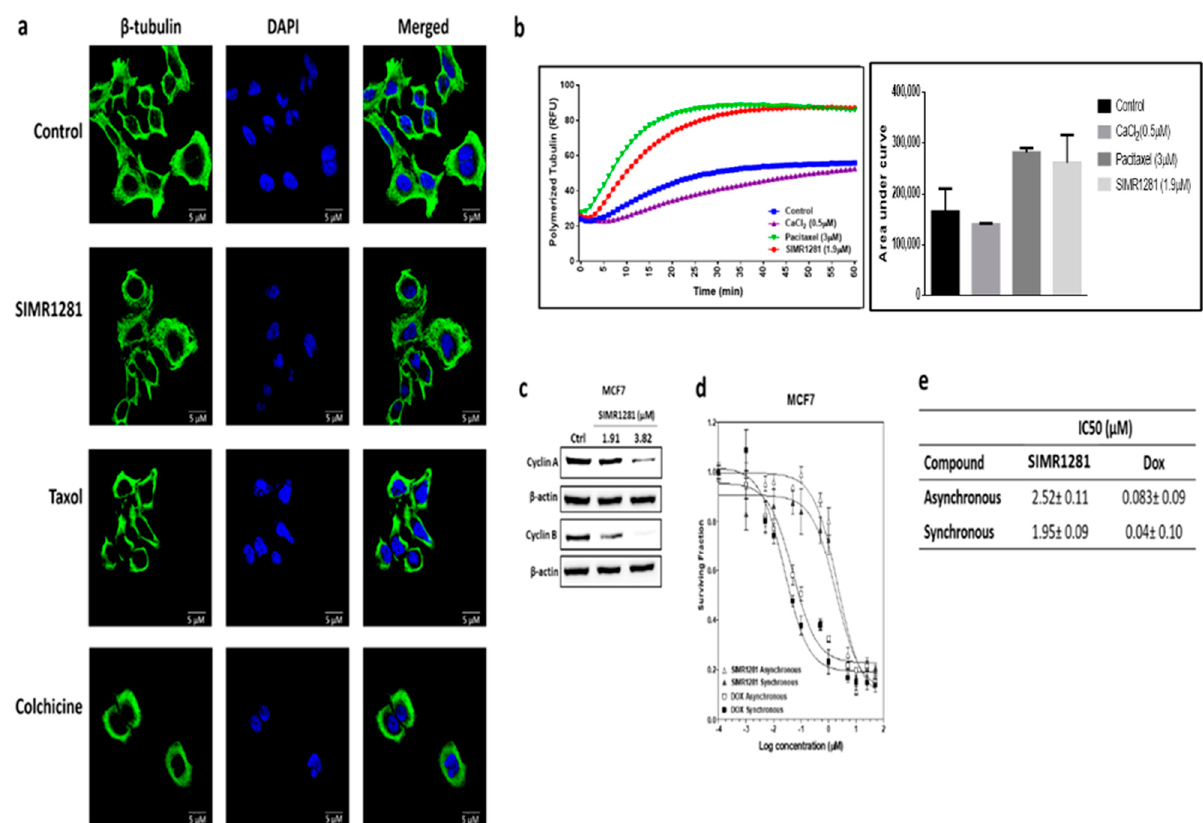
Figure 4. SIMR1281 stabilizes microtubule polymerization. ( a ) Immunofluorescence analysis of tubulin polymerization in A549 cell line after 24 h of treatment with the IC 50 concentration of SIMR1281, taxol, and colchicine (scale bar 5 µm). ( b ) Tubulin polymerization kinetic effect of the treatment with the IC 50 concentration of SIMR1281. ( c ) Western blot analysis of cyclins A and B expression levels following treatment with SIMR1281 in MCF7 cells. ( d ) Dose-dependent effect and IC 50 values of SIMR1281 and doxorubicin treatment in asynchronous and synchronous MCF7 cells. ( e ) The IC 50 of SIMR1281 in asynchronous and synchronous MCF7 cells. Data; mean ± SEM ( n = 3). Full Western blots are available in Figure S9.